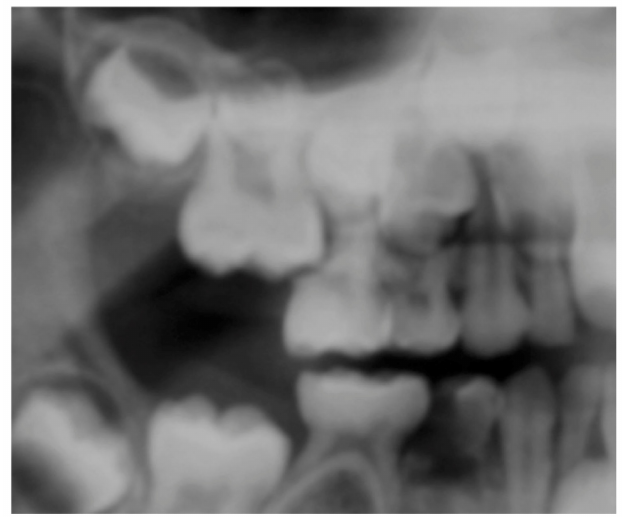
Figure 5. Example of impacted first permanent